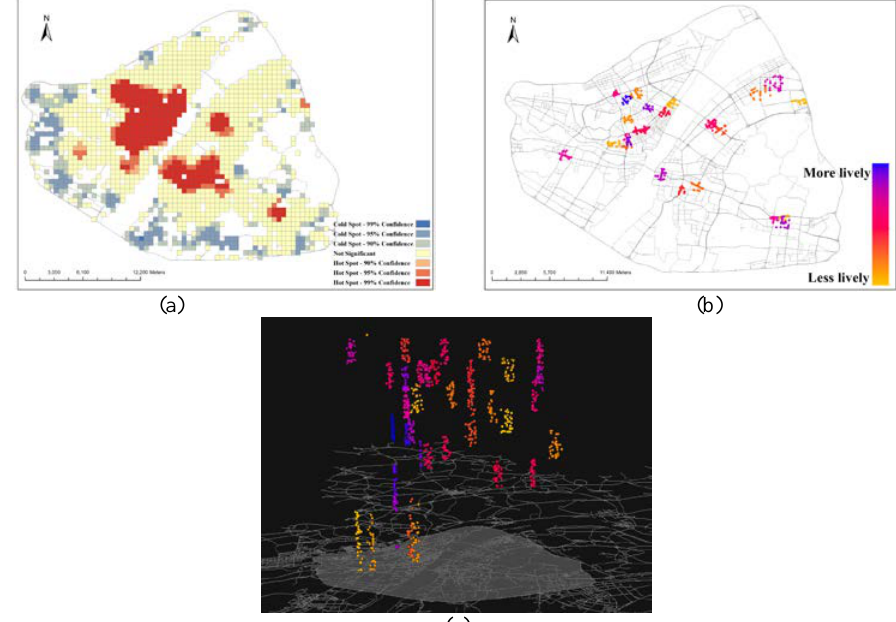
Figure 6. Comparision result between spatiotemporal data field and Getis-Ord G method. (a)Getis-Ord G calculation result. (b)spatiotemporal data field cluster result, (c)3D visualization of spatiotemporal data